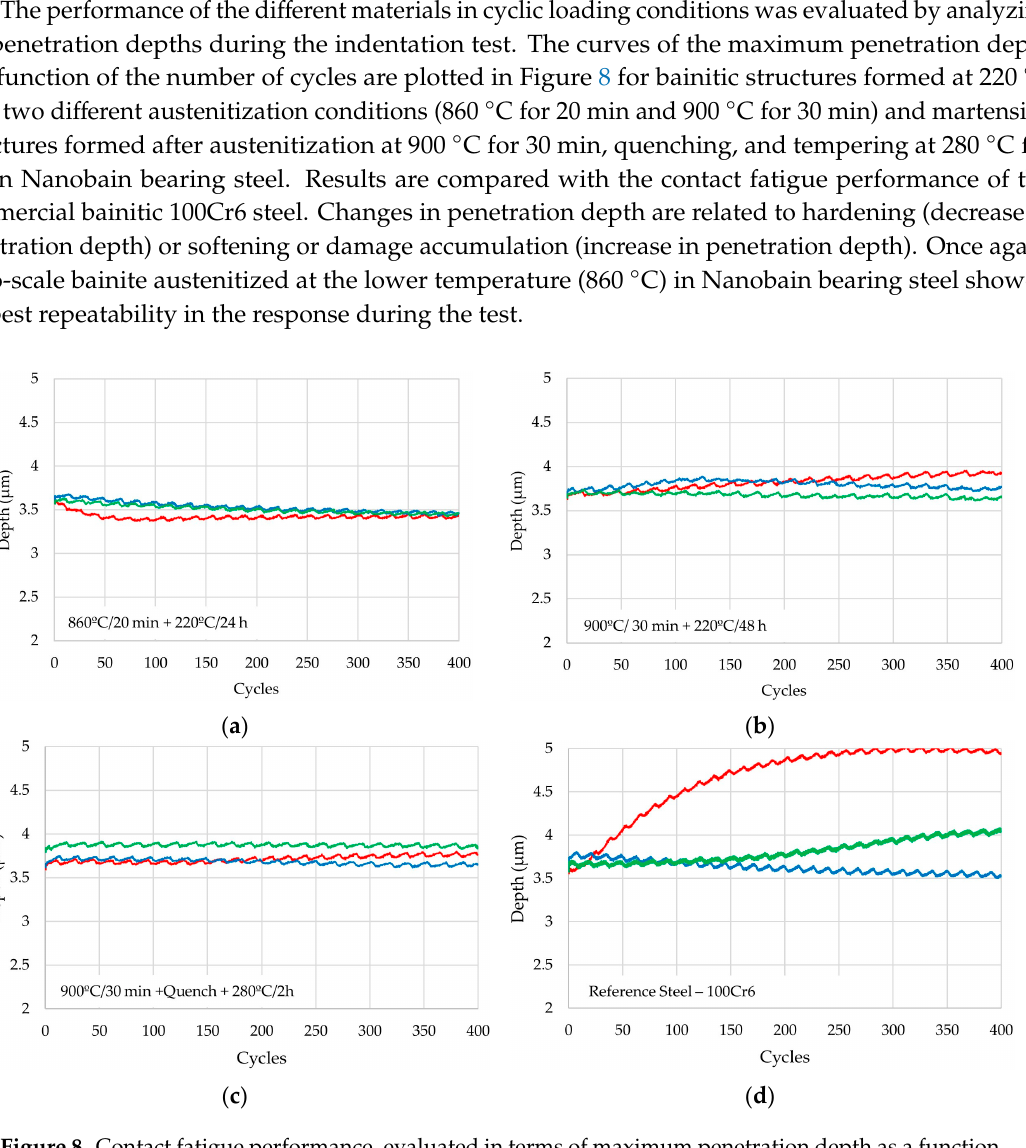
Figure 8. Contact fatigue performance, evaluated in terms of maximum penetration depth as a function of number of cycles. Nanobain bearing steel transformed to bainite at 220 °C after ( a ) austenitization at 860 °C for 20 min ( b ) and 900 °C for 30 min; and to ( c ) tempered martensite after austenitization at 900 °C for 30 min, quenching, and tempering at 280 °C for 2 h, in comparison to ( d ) commercial 100Cr6 bainitic steel. For each case, three indentations were done.